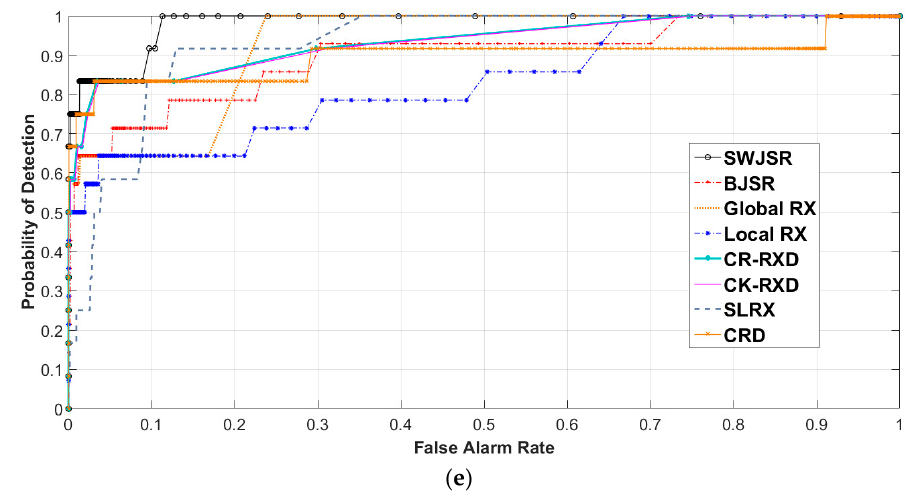
Figure 9. 2-D ROC ( P D , P F ) of the anomaly detection algorithms: ( a ) Real RIT dataset; ( b ) Real San Diego dataset; ( c ) Real Viareggio dataset; ( d ) Implanted RIT dataset; and, ( e ) Destructed RIT dataset.